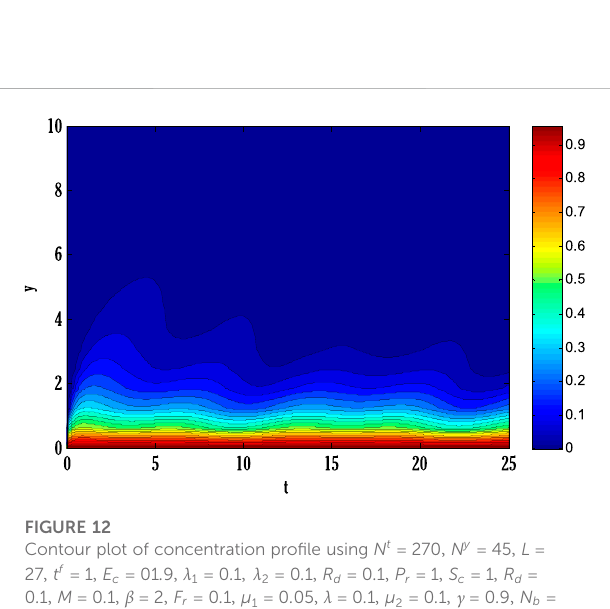
FIGURE 11 Contour plot of temperature pro fi le using N t (cid:2) 270 , N y (cid:2) 45 , L (cid:2) 27 , t f (cid:2) 1 , E c (cid:2) 01 . 9 , λ 1 (cid:2) 0 . 1 , λ 2 (cid:2) 0 . 1 , R d (cid:2) 0 . 1 , P r (cid:2) 1 , S c (cid:2) 1 , R d (cid:2) 0 . 1 , M (cid:2) 0 . 1 , β (cid:2) 2 , F r (cid:2) 0 . 1 , μ 1 (cid:2) 0 . 05 , λ (cid:2) 0 . 1 , μ 2 (cid:2) 0 . 1 , γ (cid:2) 0 . 9 , N b (cid:2)